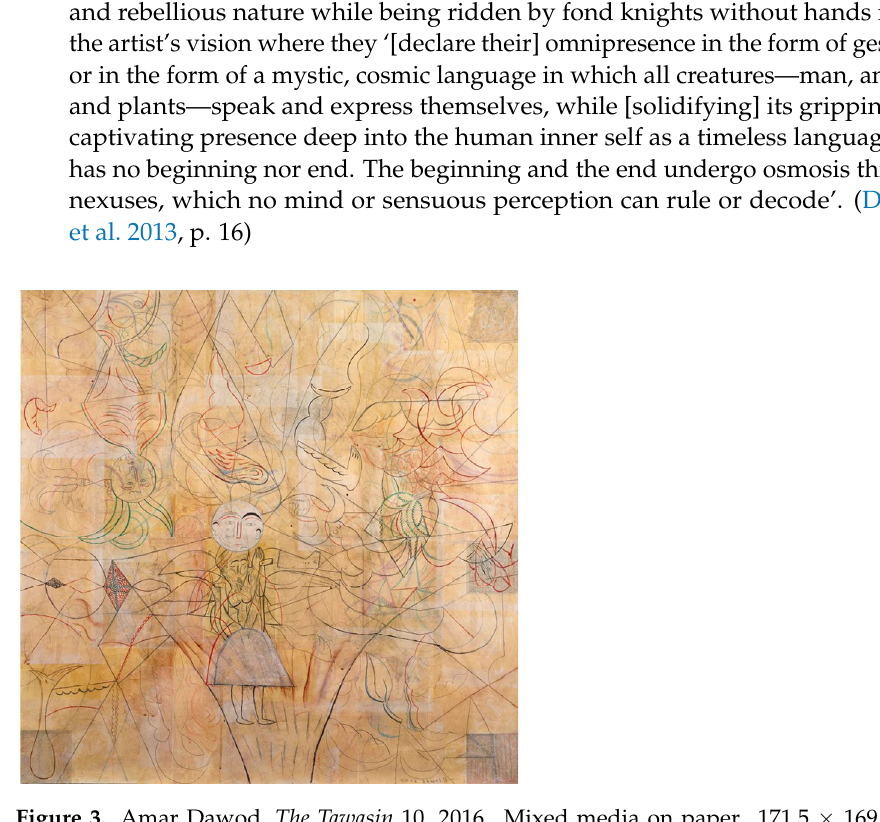
Figure 3. Amar Dawod, The Tawasin 10, 2016. Mixed media on paper. 171.5 × 169.5 × 6.5 cm. © Amar Dawod.